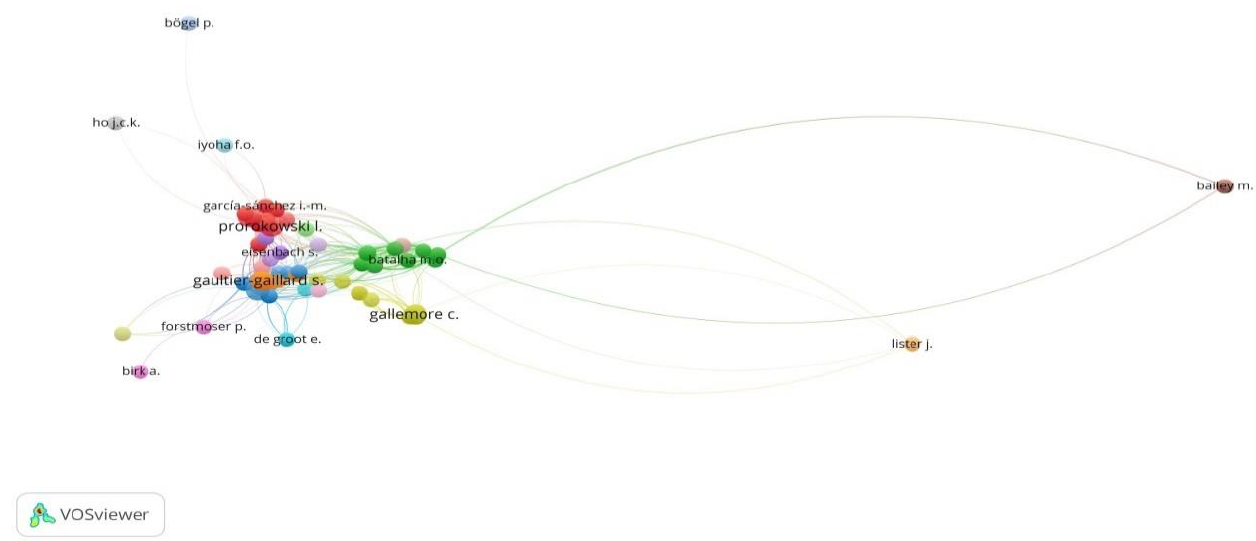
Figure 3. Search regarding